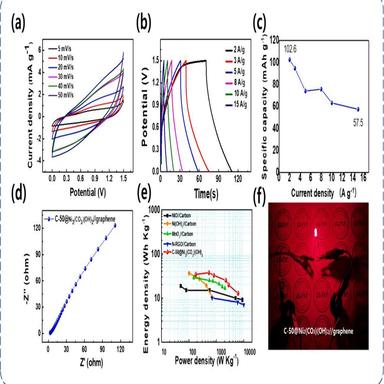
(a) CV curves of the C-50@Ni2(CO3)(OH)2//graphene ASC at different scan rates; (b) galvanostatic CD curves; (c) specific capacities; (d) EIS Nyquist plot; (e) Ragone plot; (f) LEDs powered by the C-50@Ni2(CO3)(OH)2//graphene ASC.